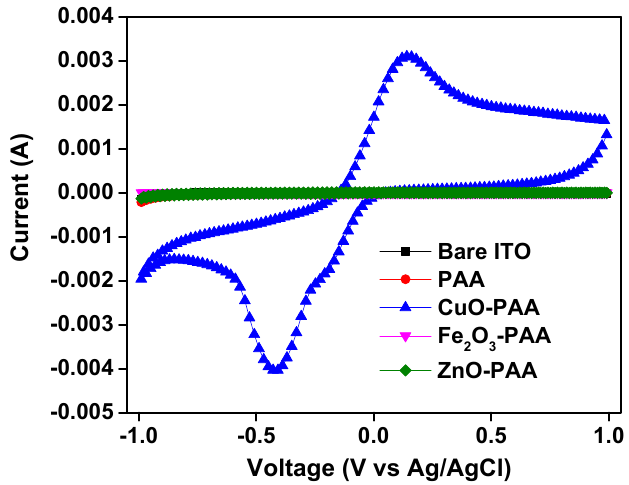
Figure 4. Cyclic voltammograms of the bare ITO, PAA, CuO–PAA, Fe 2 O 3 –PAA, and ZnO–PAA/ITO electrodes.